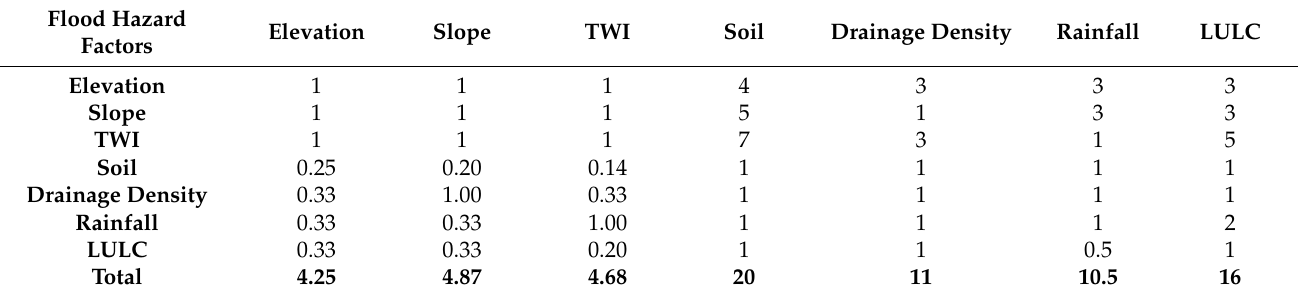
Table 1. Ranking of flood hazard contributing factors in the watershed.